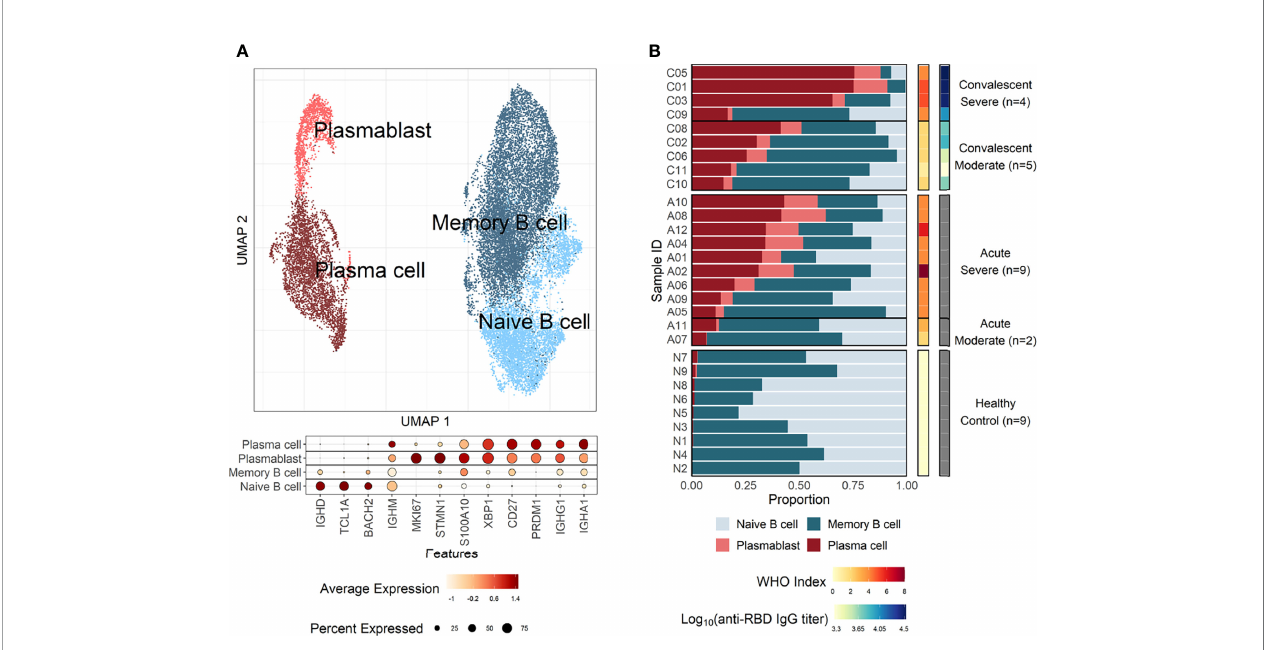
FIGURE 1 | B-cell compositions and pro fi les from COVID-19 patients and healthy individuals. (A) UMAP analysis with four clusters annotated by distinct markers of B-cell subtypes. Differentially expressed genes (DEGs) of each cluster are stated in a dot plot with diameter from the percentage of cells expressing each given gene, and with color for expression levels. (B) Proportion bar plot of four B-cell subtypes for each patient categorized by disease course and severity (WHO index). Log- scaled anti – receptor-binding domain (RBD) immunoglobulin G (IgG) titer is presented as colored code on the right-hand